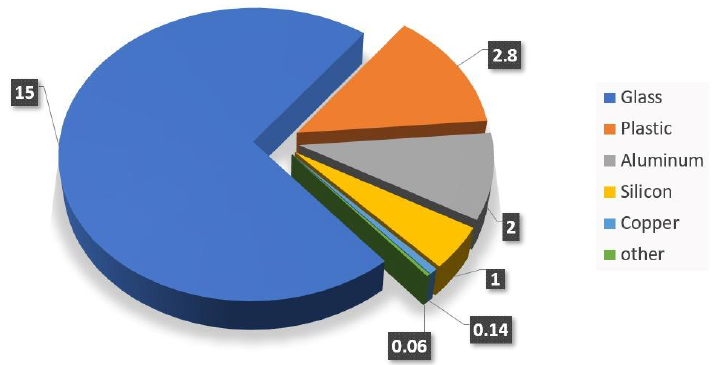
Figure 10. Recycling material from a 21 kg commercial PV panel.